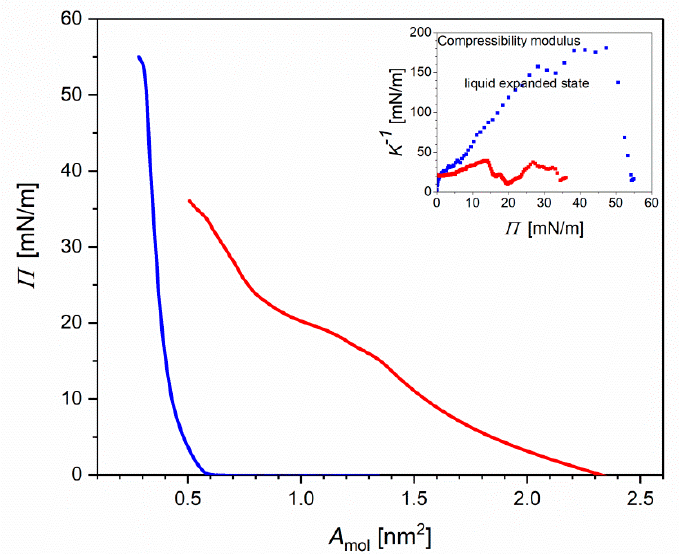
Figure 3. Surface pressure Π versus area per molecule ( A mol ) isotherms of the DMPC:GD 1a :chol (5:2:3) lipid monolayer on the aqueous (blue) and 1% aq. Piptoporus betulinus extract after 30 min of incubation (red). Inset: Compressibility modulus versus Π of the lipid monolayer on the aqueous (blue) and 1% vol Piptoporus betulinus ethanolic extract in water after 30 min of incubation (red).